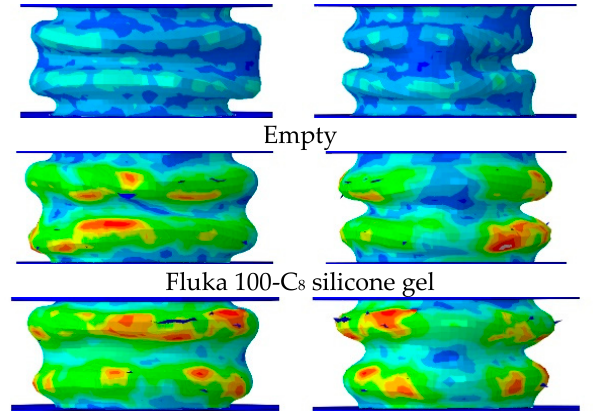
Figure 11. Stress–time curves with different salinities.